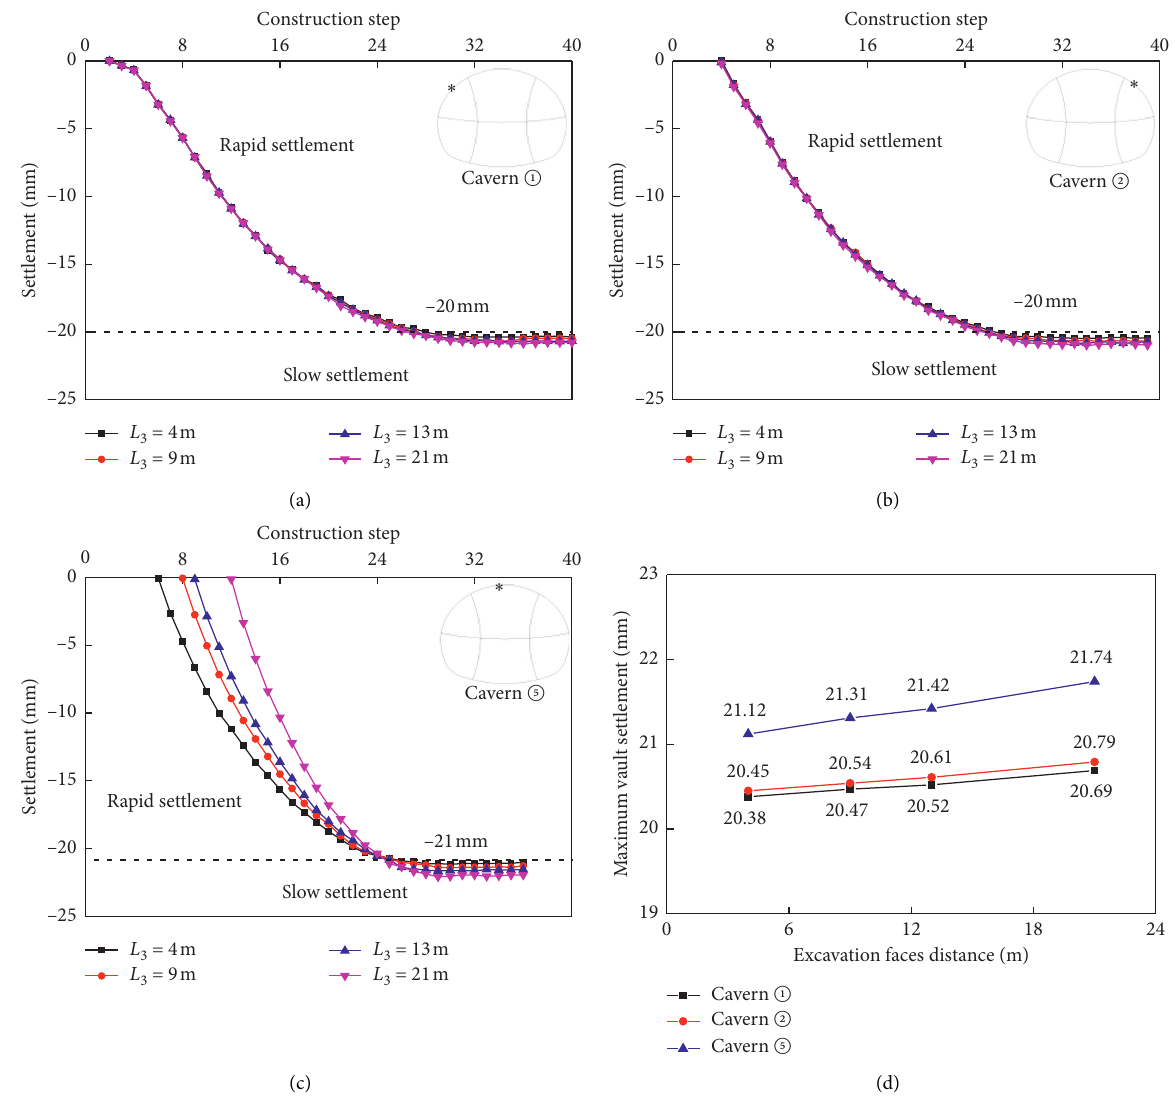
Figure 12: Vault settlement characteristics of caverns ① , ② , and ⑤ . (a) Vault settlement curve of cavern ① . (b) Vault settlement curve of cavern ② . (c) Vault settlement curve of cavern ⑤ . (d) Relationship between maximum vault settlement and excavation face distance ( L 3